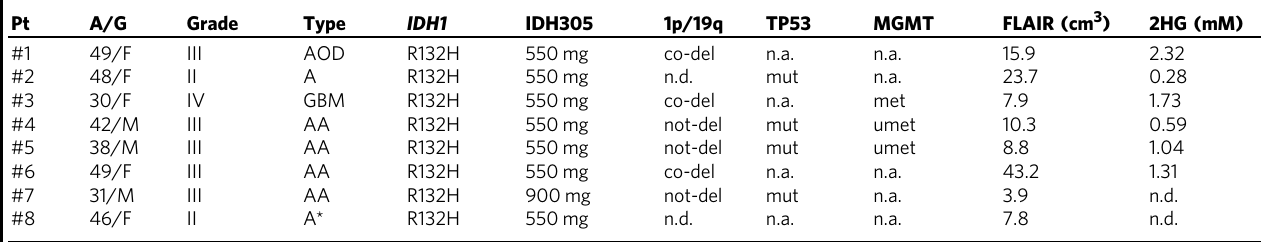
Table 1 Demographic, histology and molecular markers of